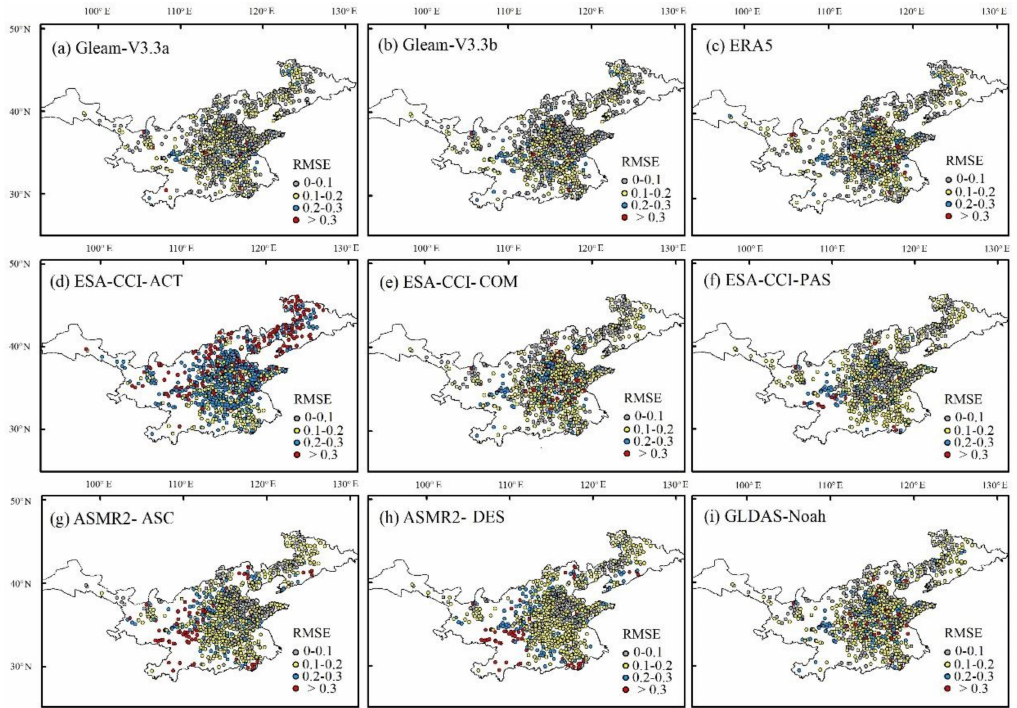
Figure 8. Spatial distribution of RMSE between multi-source SM products and in situ ground observations. Four classes are included in RMSE evaluation: (0, 0.1]; (0.1, 0.2]; (0.2, 0.3];